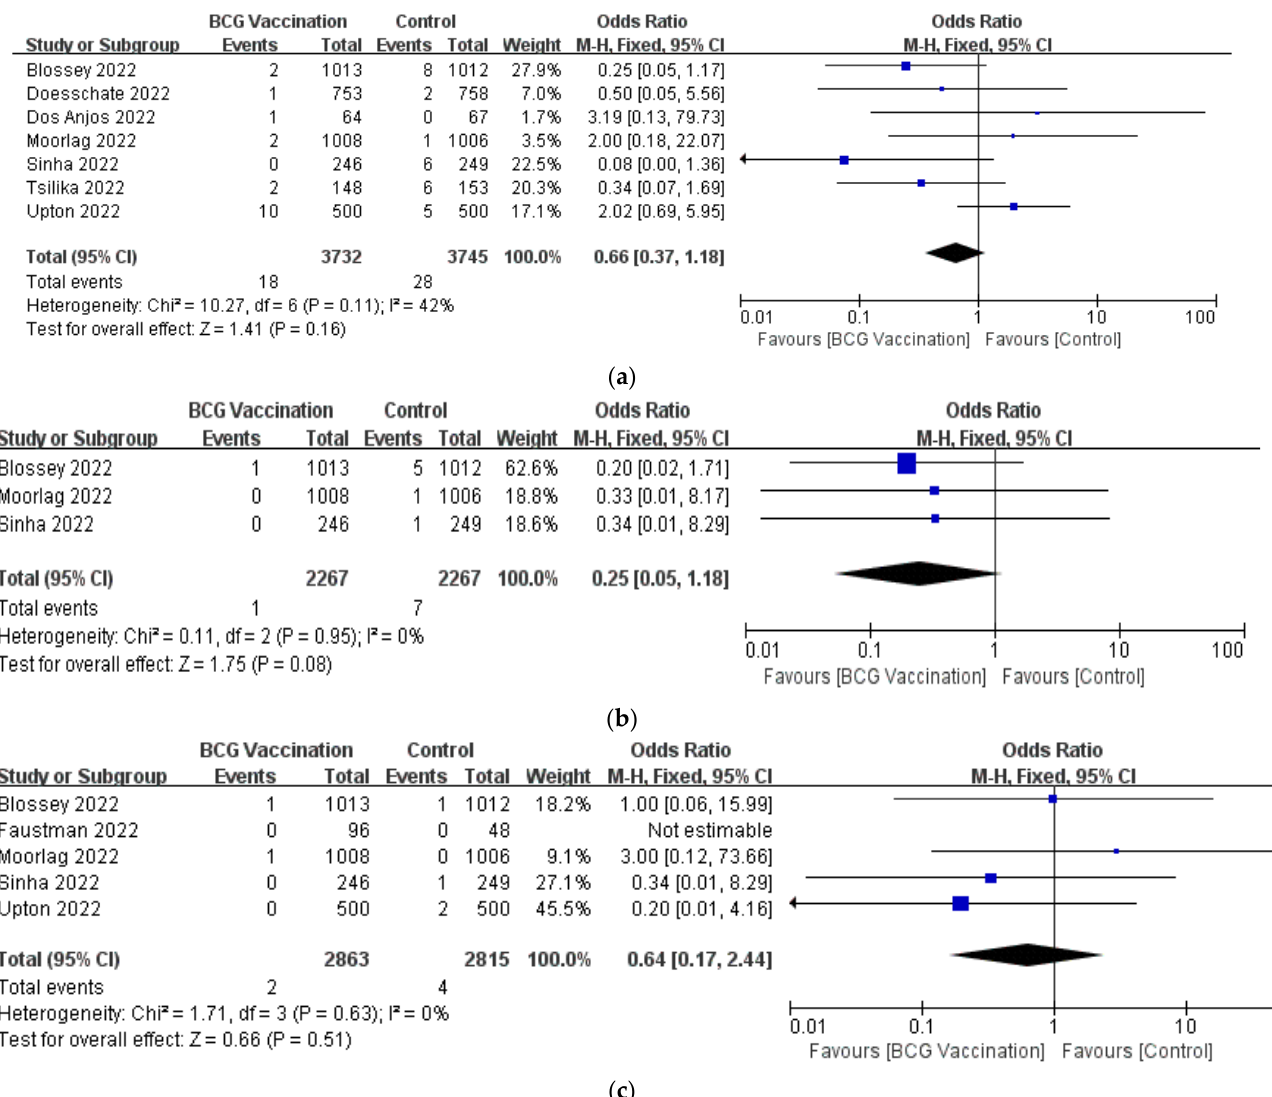
Figure 4. Forrest plot of the odds ratio of the ( a ) hospitalization; ( b ) admission to the ICU; ( c ) mortality of COVID-19 between the BCG vaccination group and the control group.